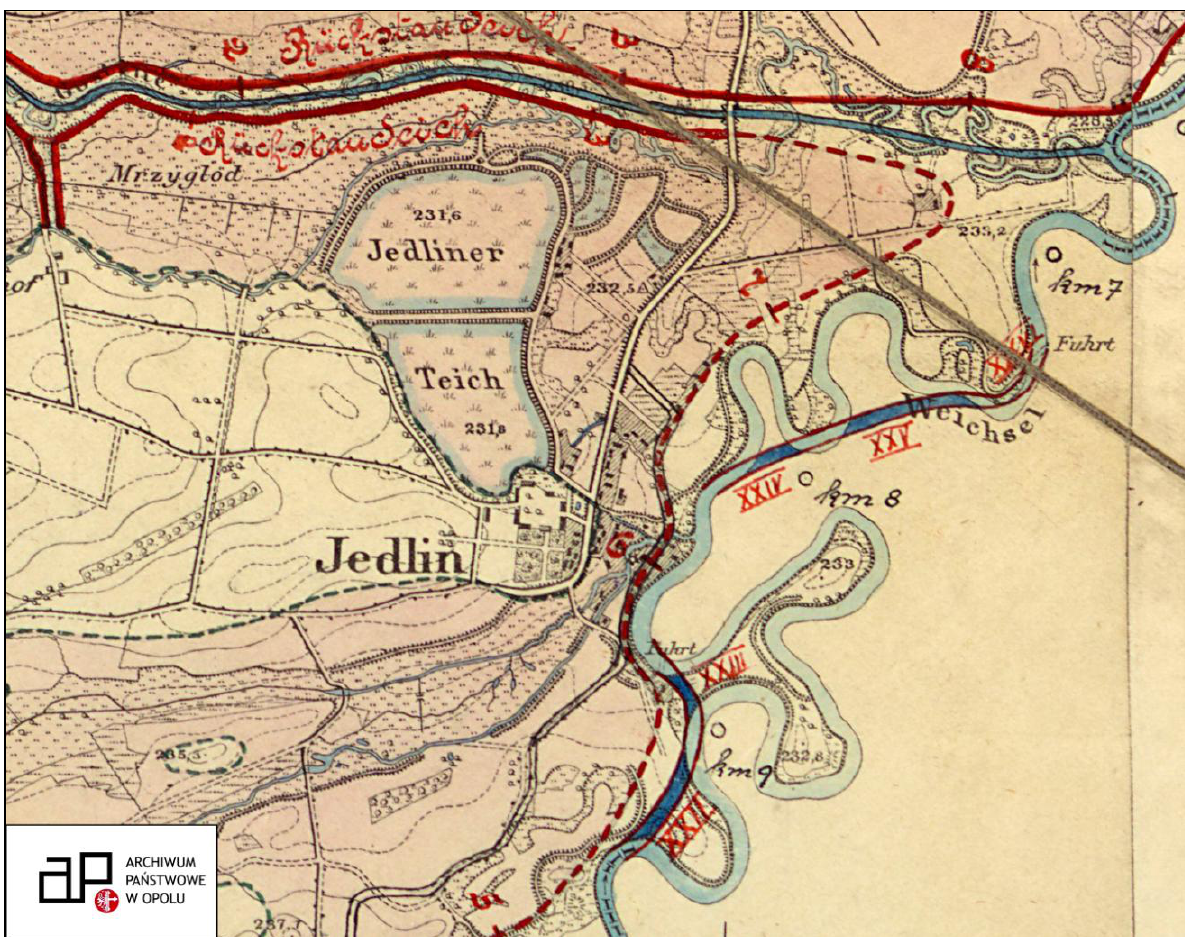
Fig. 8. Hydraulic structures within the River Vistula valley and in the final reach of the River Pszczyna in the vicinity of Jedlina (after Regulierung der…, 1907–1908, original scale: 1:25 000, State Archives in